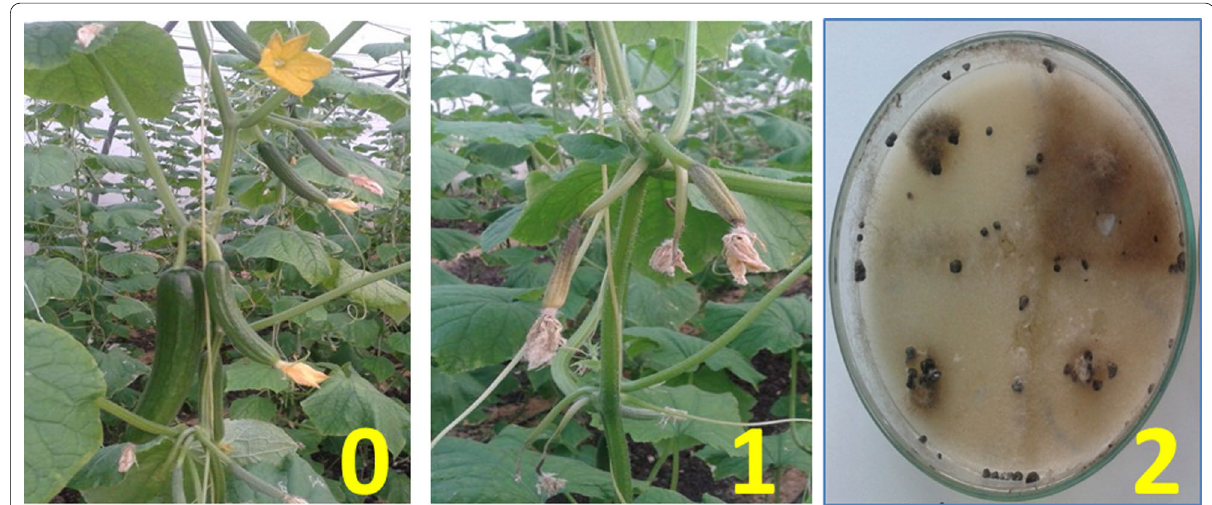
Fig. 1 Cucumber healthy fruits (0) , Botrytis grey mould disease symptoms cucumber fruits showing yellowish, brownish and death on fruit still attached on cucumber plants fruits (1) and (2) culture of causal fungal pathogen ( B. cinerea )